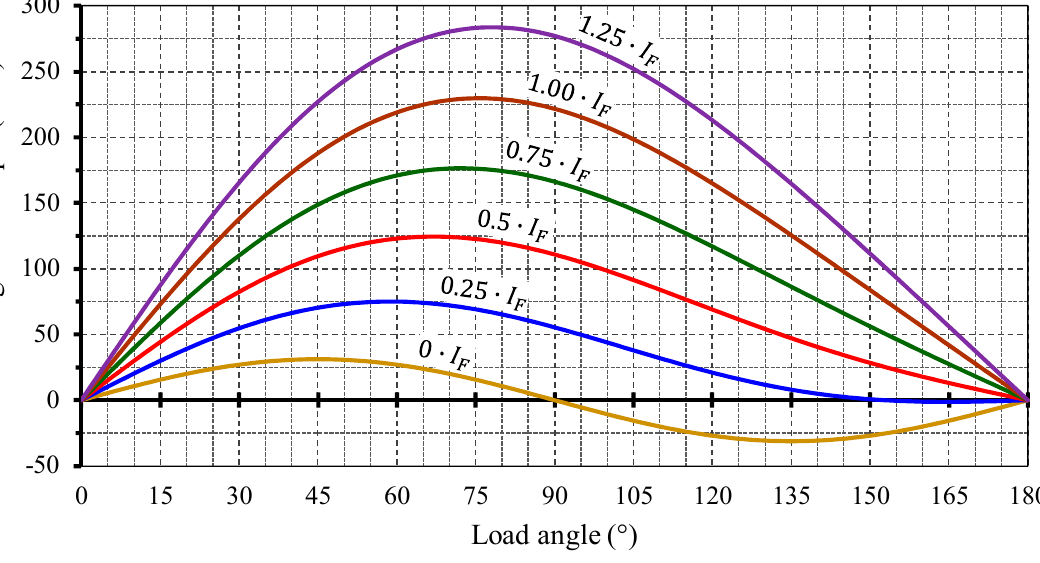
Figure 9. Electromagnetic torque as a function of load angle.